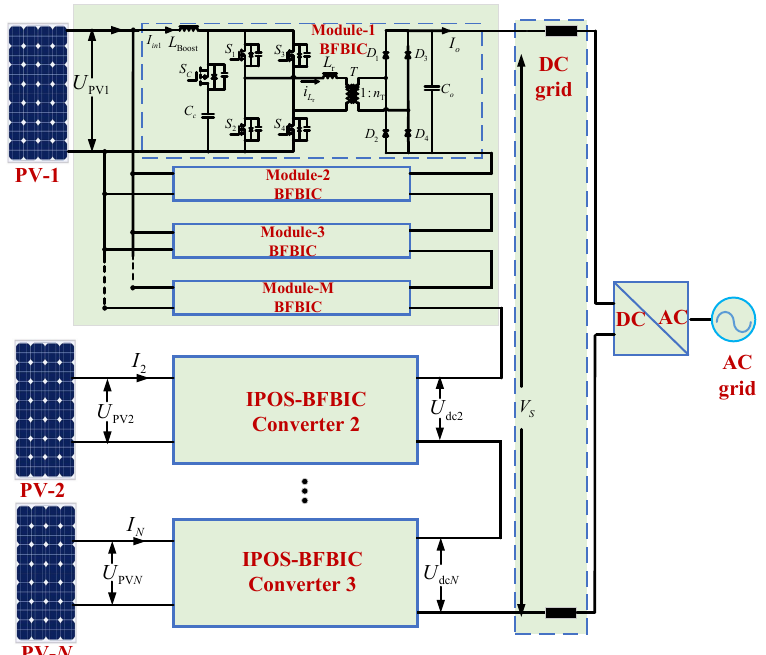
Figure 3. Structure of a series photovoltaic DC boost collection system. IPOS: input parallel output series, PV: photovoltaic.